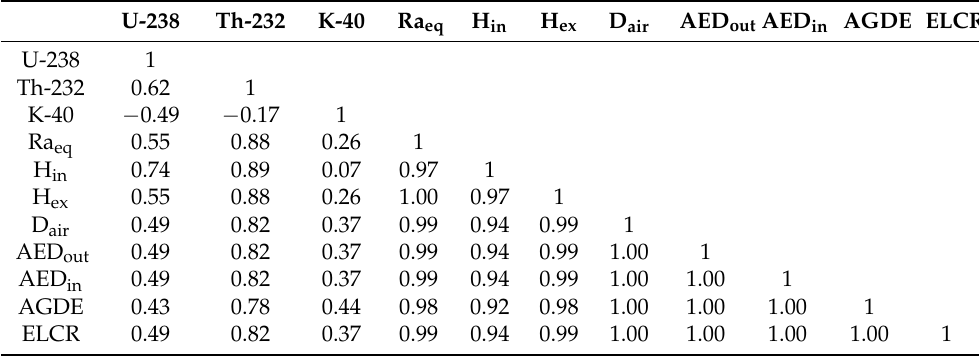
Table 5. Pearson correlation between natural radionuclides and the radiological hazards coefficients of pegmatite rocks, studied area,